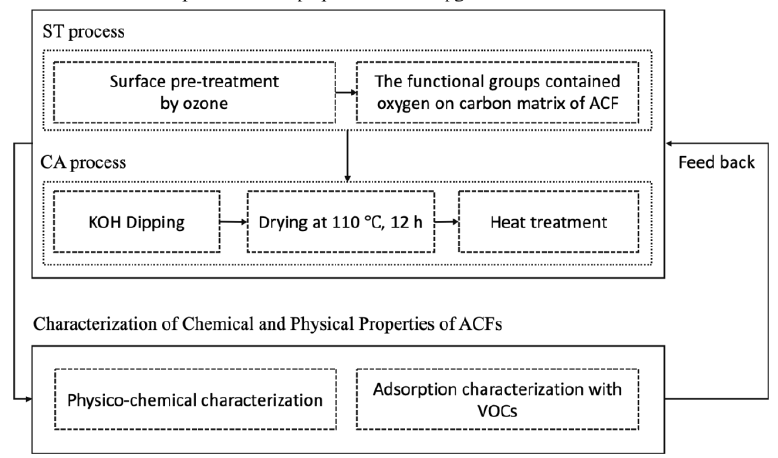
Figure 1. Proposed framework for Successive ST-CA (surface treatment-chemical activation) process for the preparation of the modified ACFs (Activated carbon fibers). Volatile organic compounds